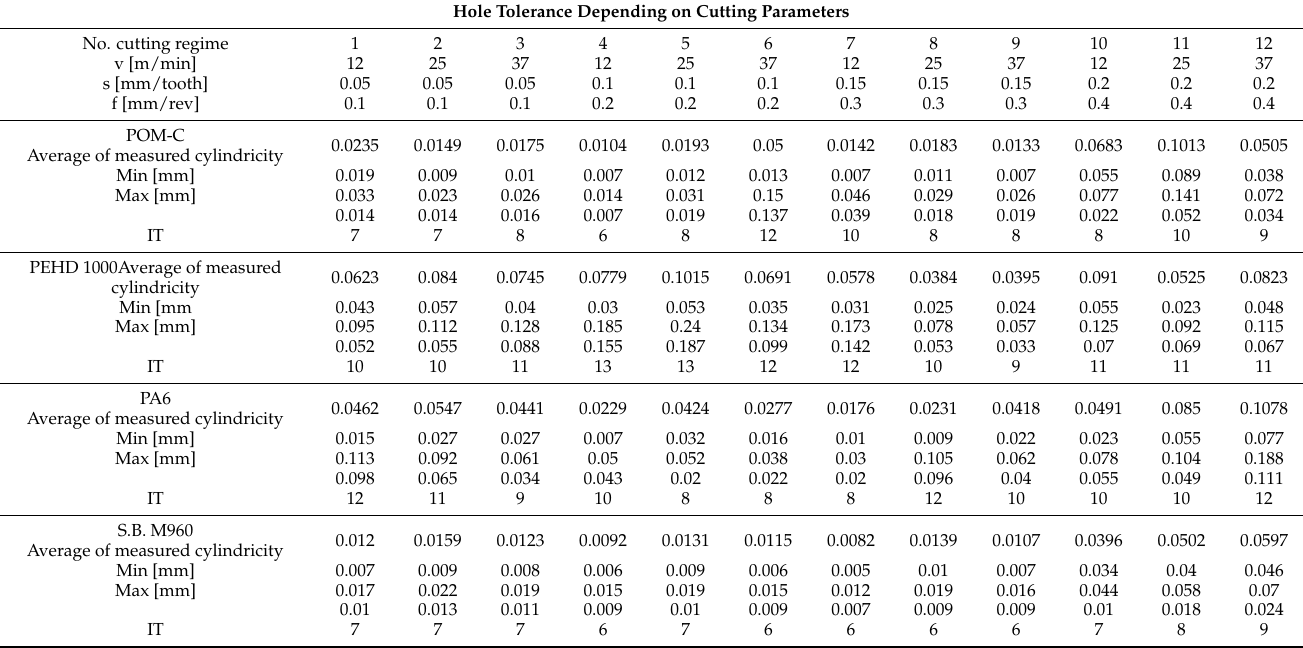
Table 11. Centralizing table of hole tolerances depending on the cutting regime. Hole Tolerance Depending on Cutting